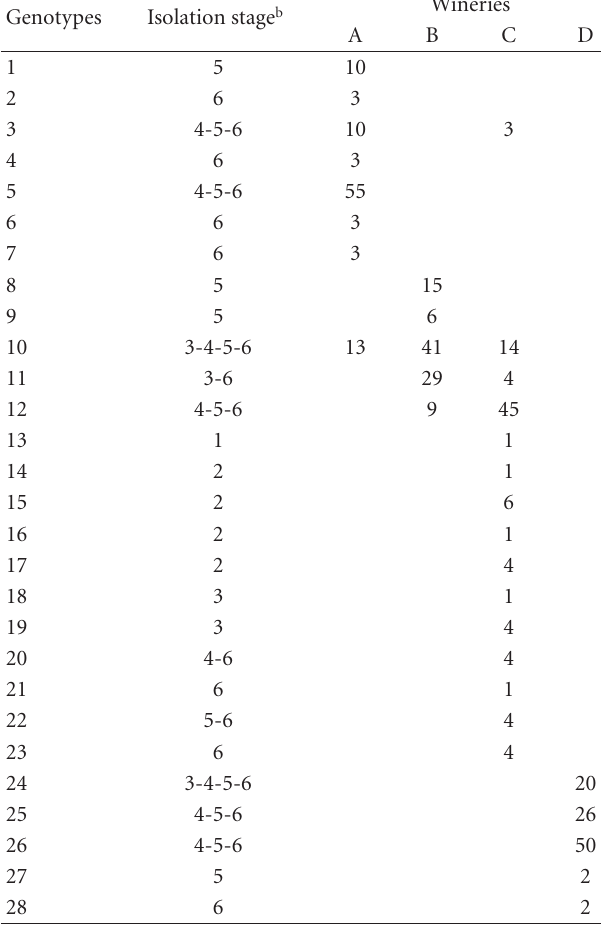
is the strains belonging to type “j.” (—) incalculable. Table 4: O. oeni genotypes, isolation stage, and frequency a (%) of their appearance in each winery.